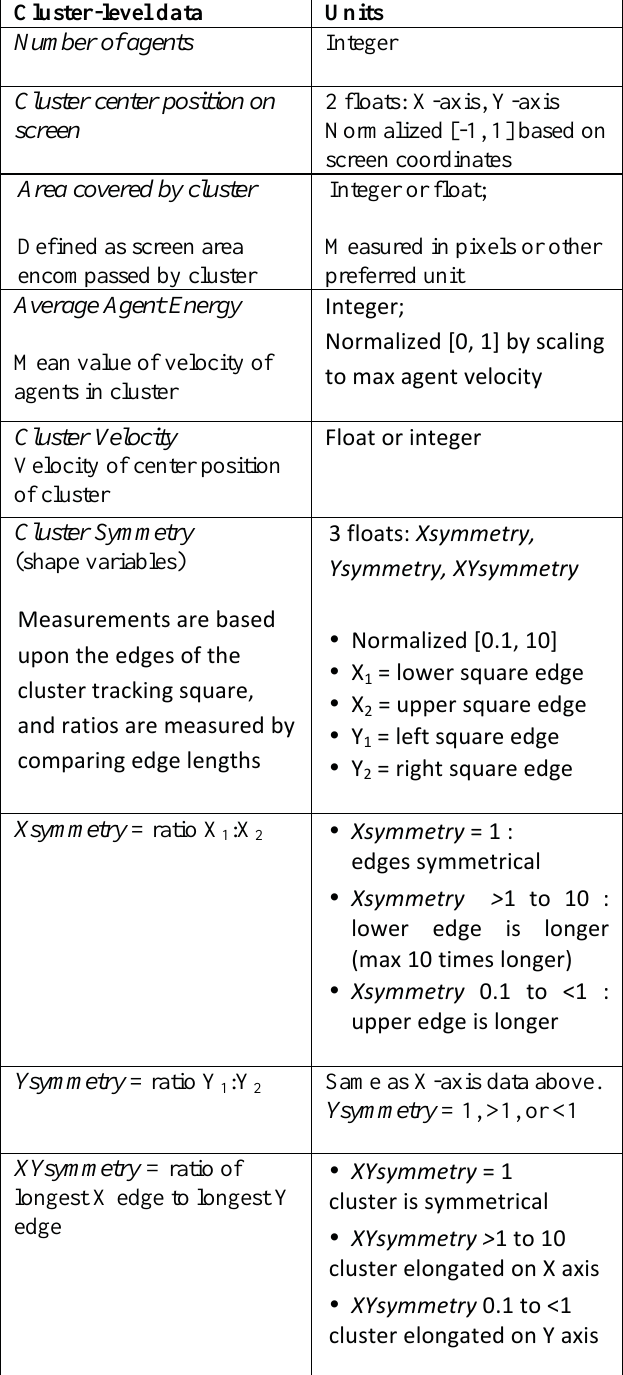
Table 2. Data Extracted for Procedural Sound